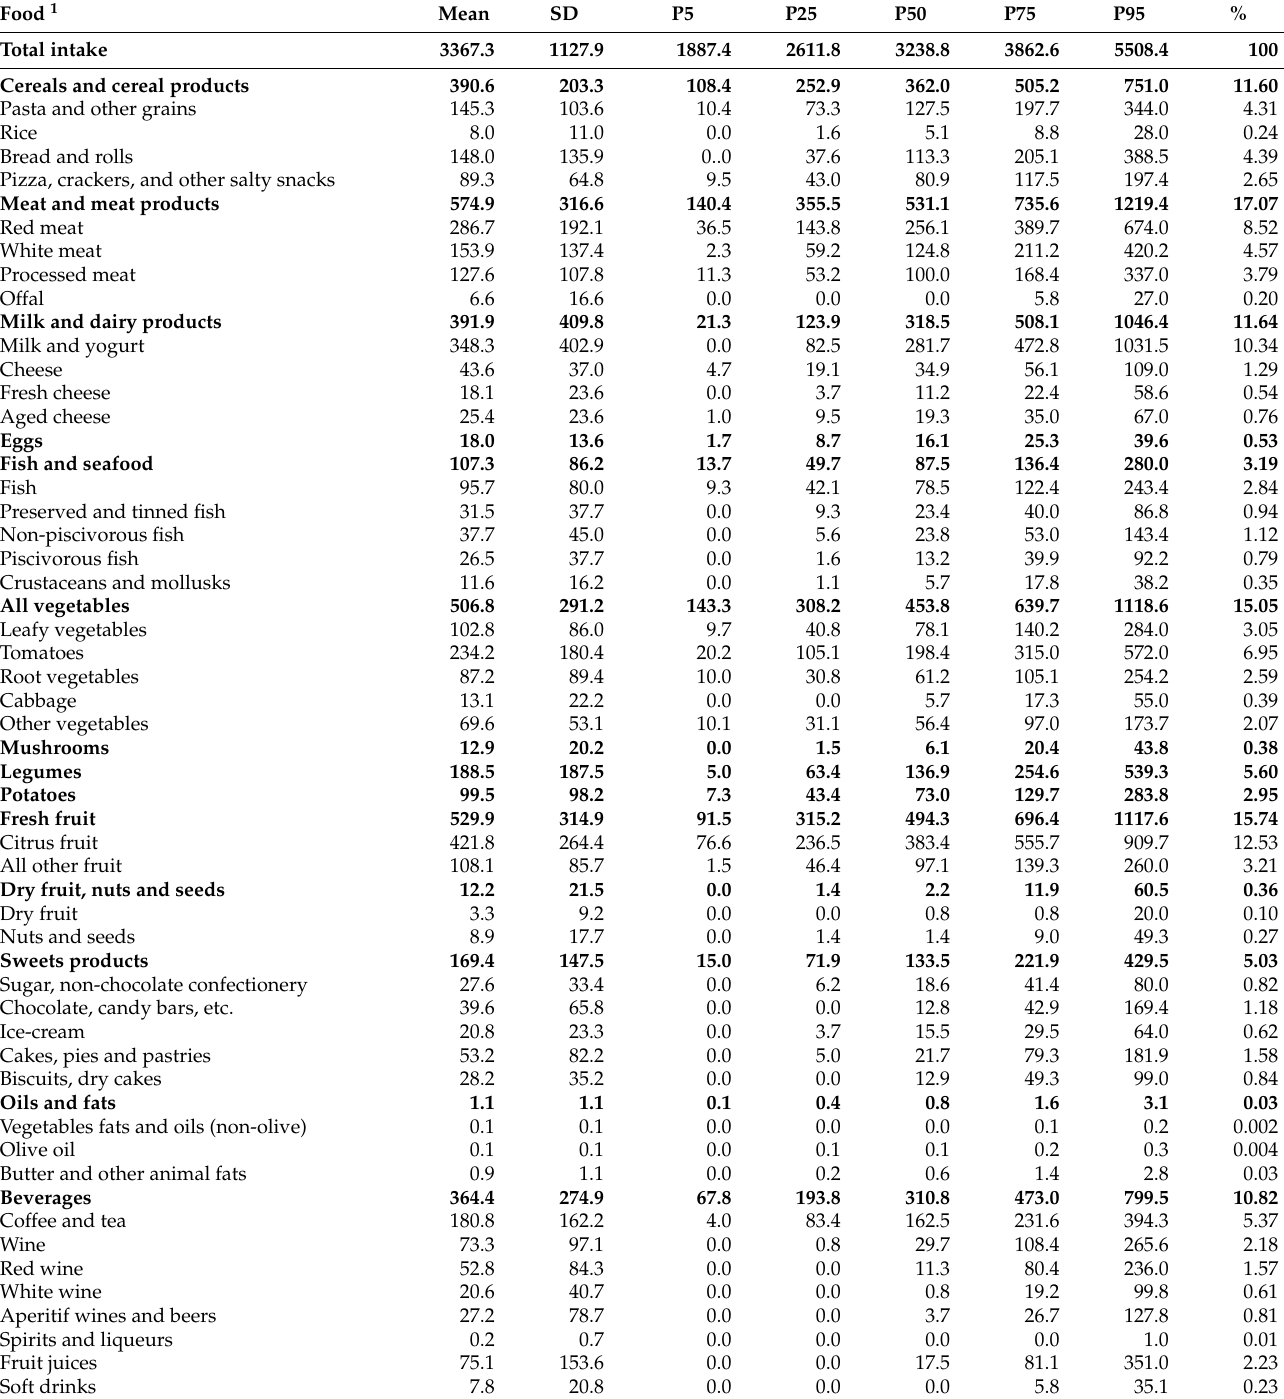
Table 4. Distribution of potassium daily dietary intake in all subjects (in mg/day) and percentage contribution (%) of each food to total